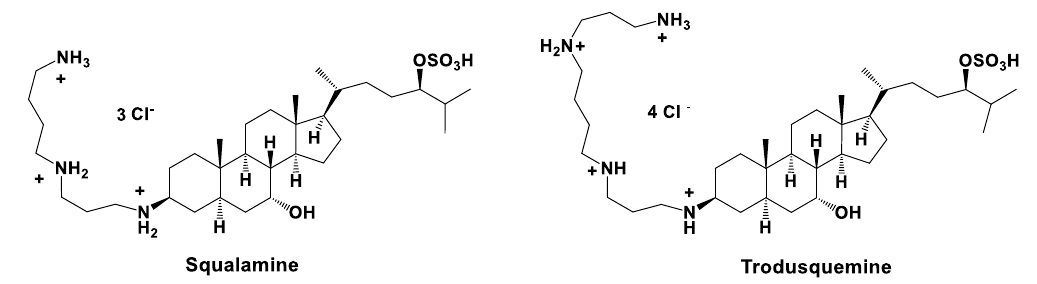
Figure 1. Structure of squalamine and trodusquemine.